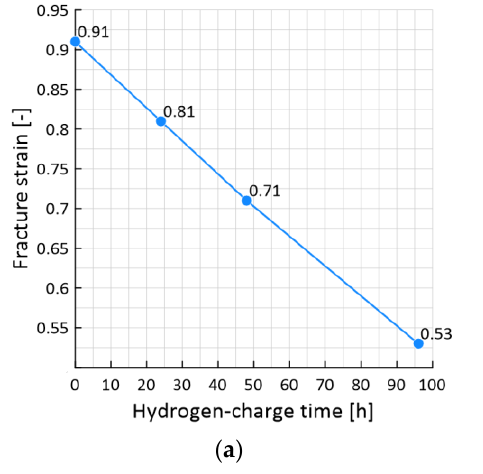
Figure 9. The effect of hydrogen-charge time on the fracture strain: with 0% ( a ) and 75% ( b ) pre- strain samples.